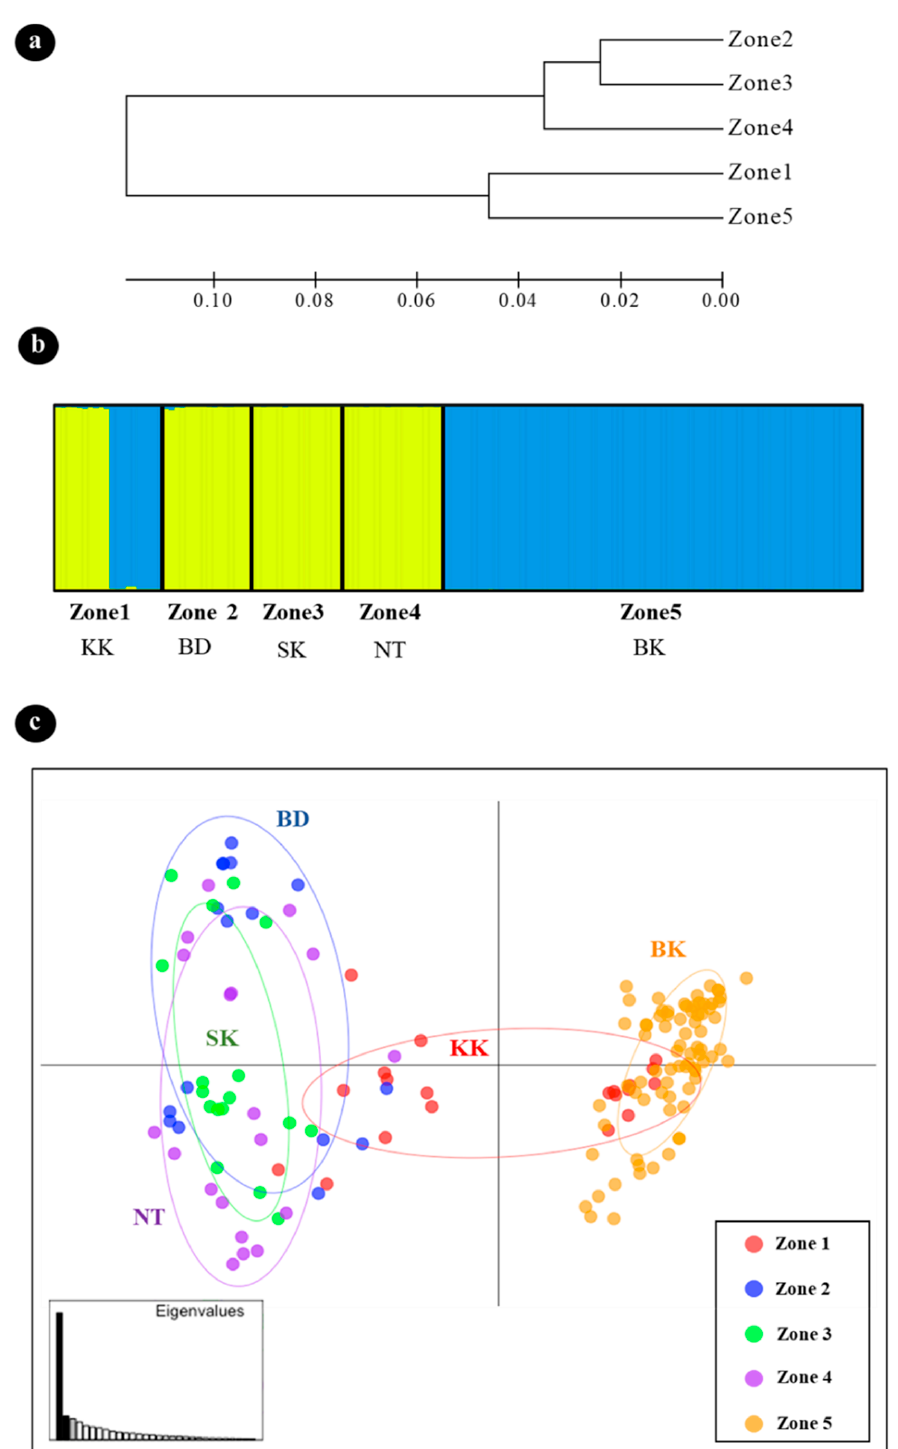
Figure 1. UPGMA-based dendrogram of genetic distances and population structure of leatherback turtles in the Andaman Sea. ( a ) UPGMA cluster analysis based on Nei’s genetic distances among five zones. Zone 1 = Khuk Khak Beach; Zone 2 = Bor Dan Beach; Zone 3 = Sai Keaw Beach; Zone 4 = Nai Thon Beach; Zone 5 = Bang Kwan Beach; ( b ) Population structure of leatherback turtle population for K = 2 using STRUCTURE software. Each individual is represented by a single vertical bar divided into K colors (blue and yellow); ( c ) Principal component analysis plot (autosomal microsatellite data). The five genetic clusters by zones of the leatherback